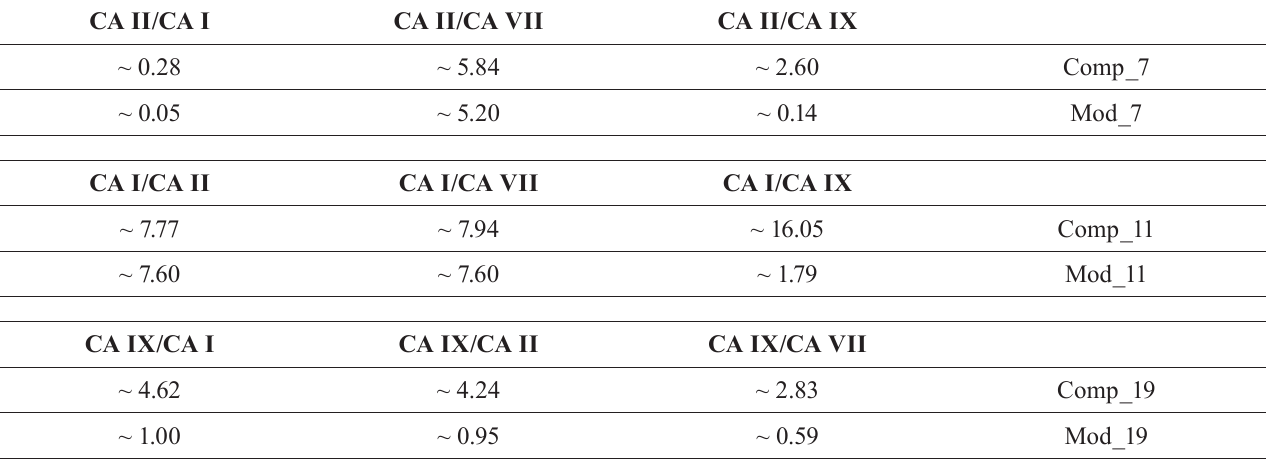
TABLE I - E xperimental/experimental and predicted/predicted ratio values of Kis for original (Comp) and modified (Mod) compounds,